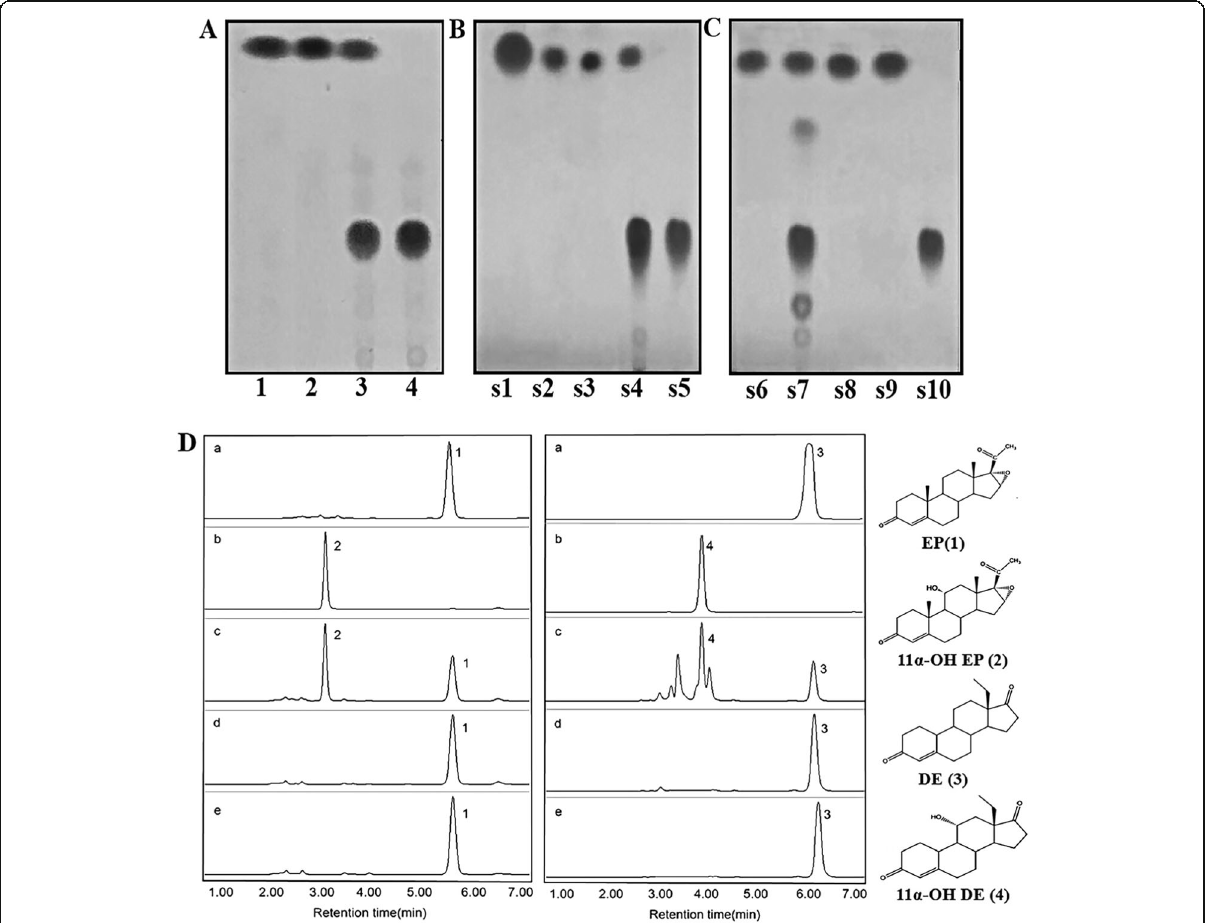
Fig. 2 Identification of steroid 11 α – hydroxylase gene CYP68J5 . a TLC analysis of induction of steroid 11 α – hydroxylase activities in TCCC41060. 16,17 α -epoxyprogesterone (EP) was used for induction and also as transformation substrate, and petroleum and ethyl acetate (3:2) was used for product separation. 1, EP standard; 2, induction for 0 h; 3, induction for 3 h; and 4, 11 α -OH EP standard. b , c Analysis of bioconversion products of the recombinant S. cerevisiae cells expressing either CYP68L8 or CYP68J5 . b EP as substrate, petroleum and ethyl acetate (3:2) as the solvent system for TLC; s1, EP standard; s2, S. cerevisiae wild-type; s3, recombinant INVSc1- CYP68L8 ; s4, INVSc1- CYP68J5 ; and s5, 11 α -OH EP standard. c DE as substrate and petroleum and ethyl acetate (1:1) as the solvent system; s6, DE standard; s7, INVSc1- CYP68J5 ; s8, S. cerevisiae wild-type; s9, recombinant INVSc1- CYP68L8 ; and s10, 11 α -OH DE standard. d HPLC assays of biotransformation product of recombinant S. cerevisiae cells, acetonitrile: H 2 O 80:20 (v/v) as the mobile phase . (a) substrate standards (1) EP, (3) DE; (b) 11 α -hydroxy-products standards (2) 11 α -OH EP, (4) 11 α - OH DE; (c) recombinant S. cerevisiae INVSc1- CYP68J5 , (d) S. cerevisiae wild-type, and (e) recombinant S. cerevisiae INVSc1-